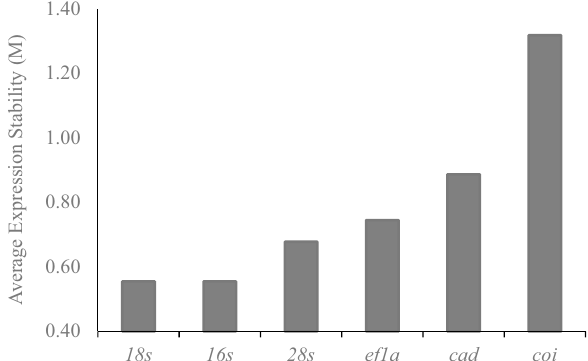
Figure 4. Average expression stability values (M) of the 6 candidate reference genes plotted from most stable (left) to least stable (right) analyzed by the GeNorm software.